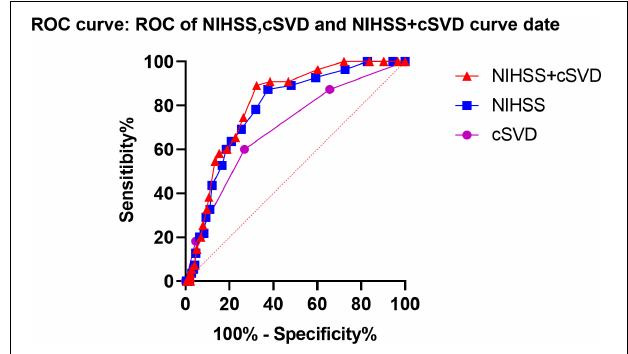
FIGURE 3 | Predictive performances of NIHSS score, SVD burden and a combined NIHSS score, and SVD burden using ROC analysis. ROC, receiver operating characteristic; cSVD, cerebral small vessel